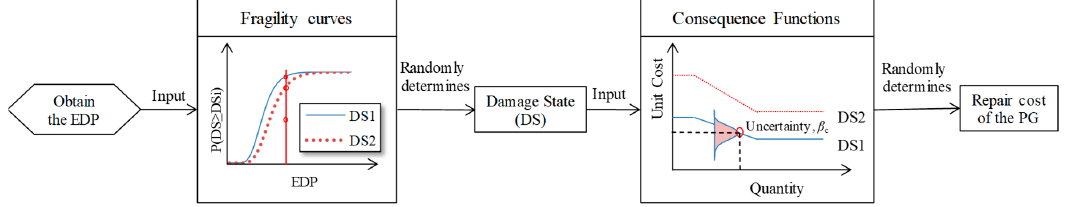
Figure 7. Calculation of repair cost for a building component using the FEMA-P58 methodology.